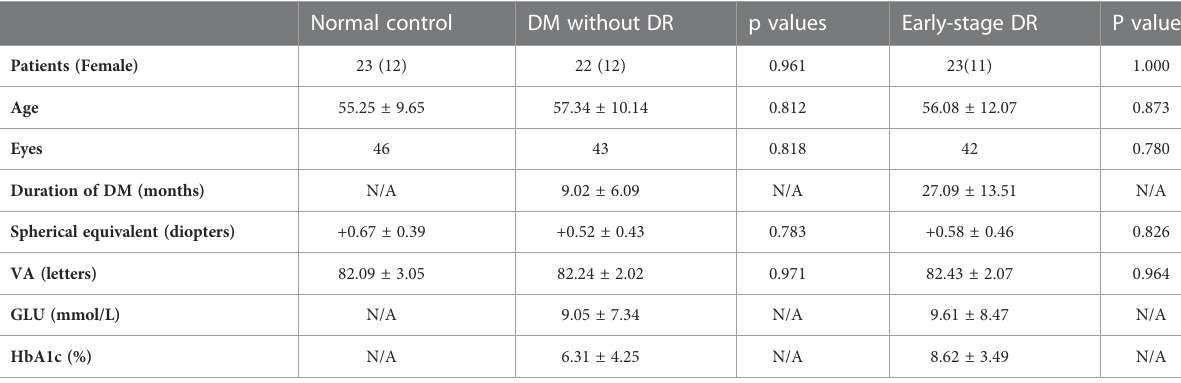
Values are presented as the means ± standard deviations at baseline in different groups. DM, diabetes mellitus; DR, diabetic retinopathy; VA, Visual acuity; in Early Treatment Diabetic RetinopathyStudy(ETDRS)units;GLU,Glucose;HbA1c,HemoglobinA1C.StatisticaldifferenceswereanalyzedbetweenthepatientswithDMandthenormalcontrol,p<0.05indicates statistically signi fi cant difference. NA, not